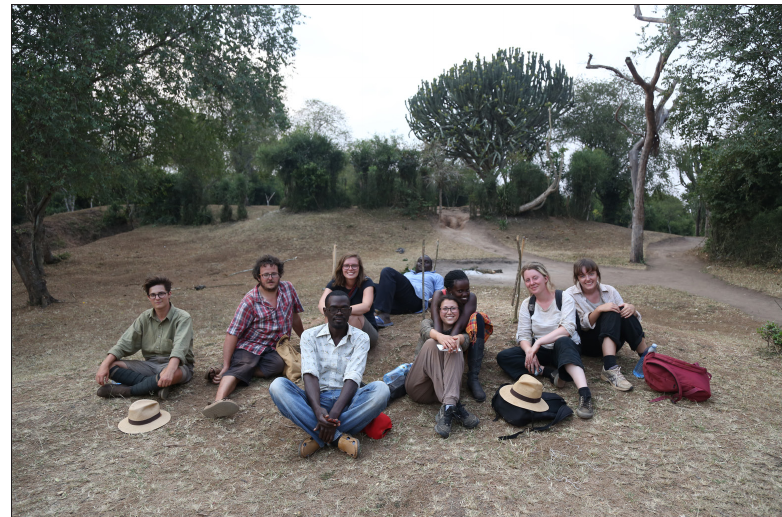
Figure 1: IoA students on a break during fieldwork in Uganda, Ntuusi, 2017 (Photo: Wei Ping Young).